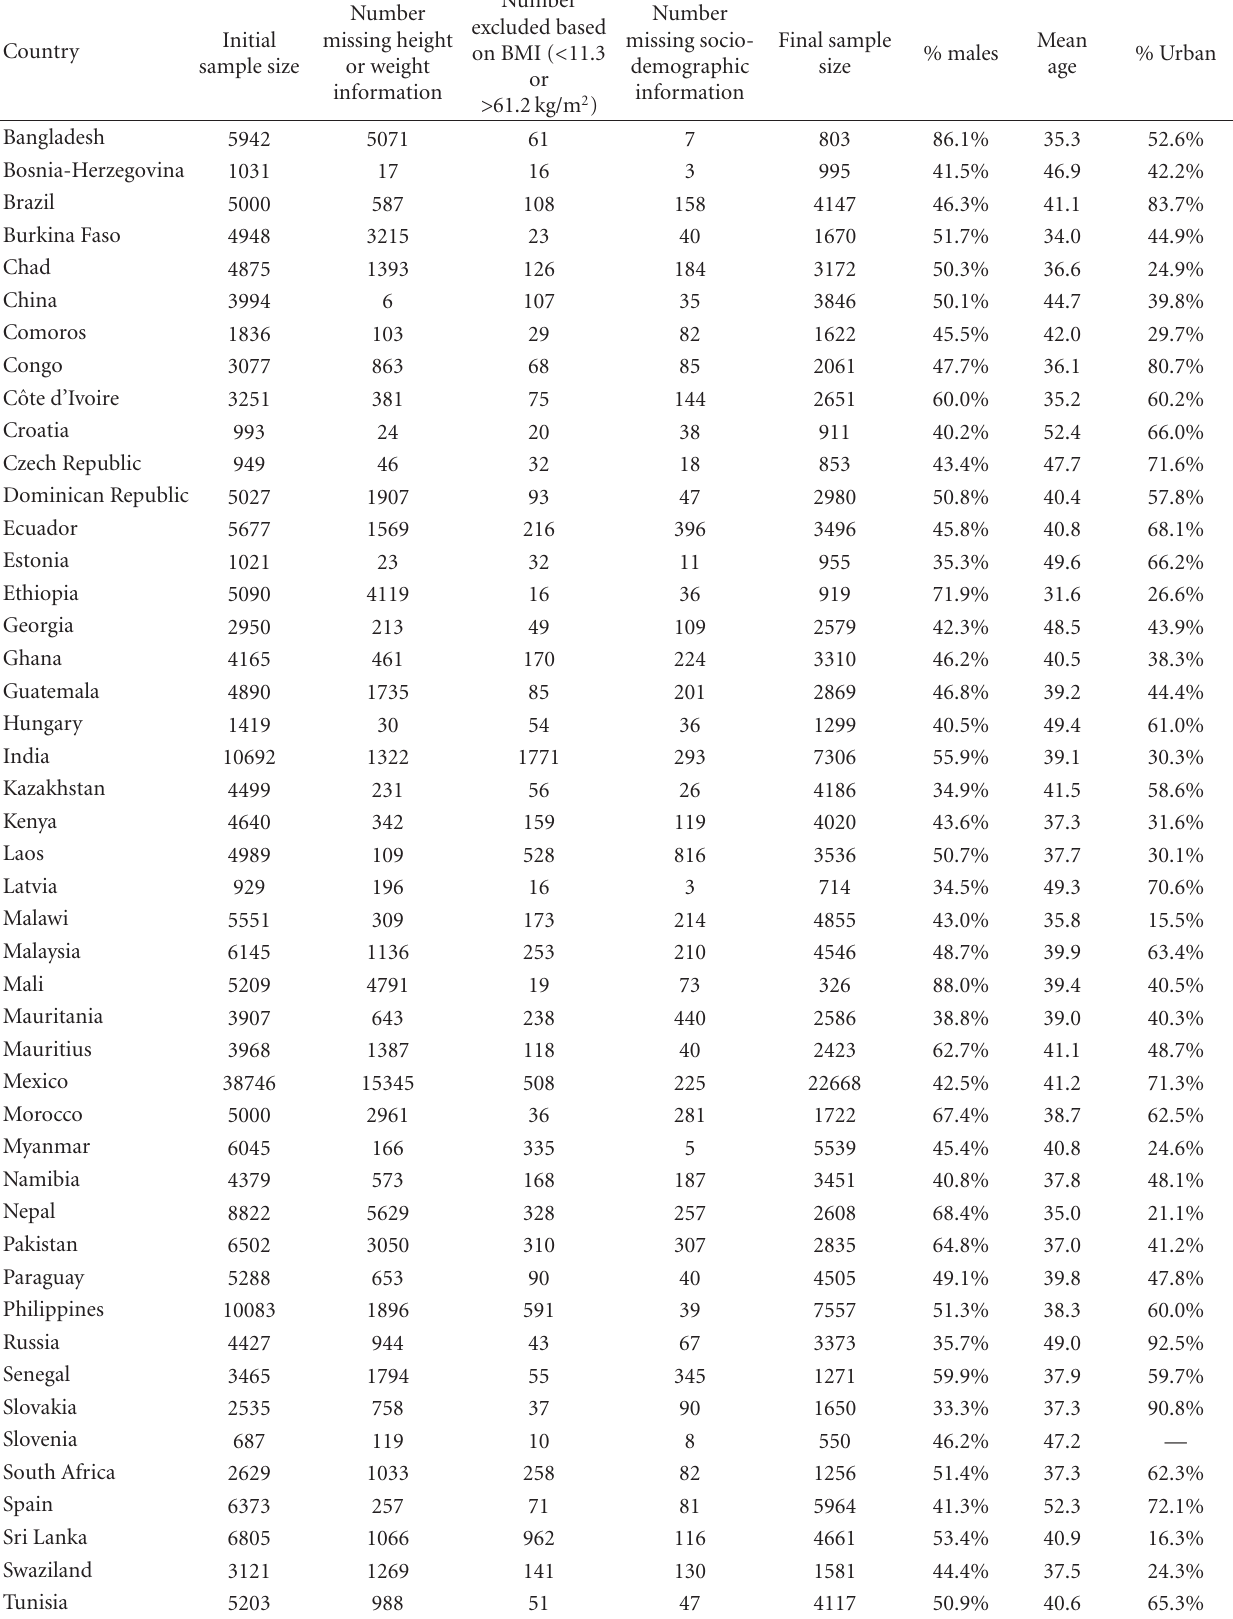
Table 1: Characteristics of WHS body mass index (BMI) sample, by country and in total, WHS,